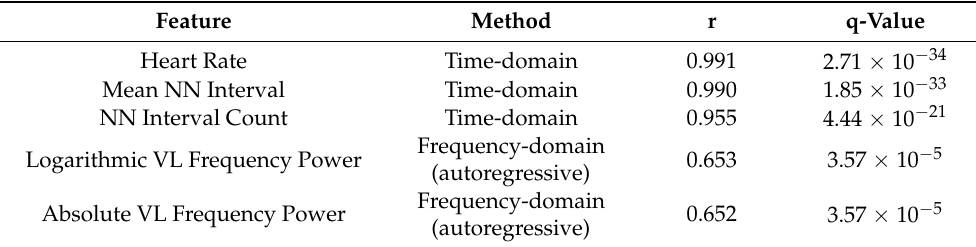
Table 3. Top five features according to the Pearson correlation test.